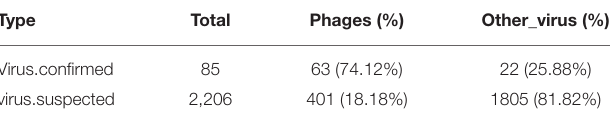
TABLE 4 | Virus category statistics.